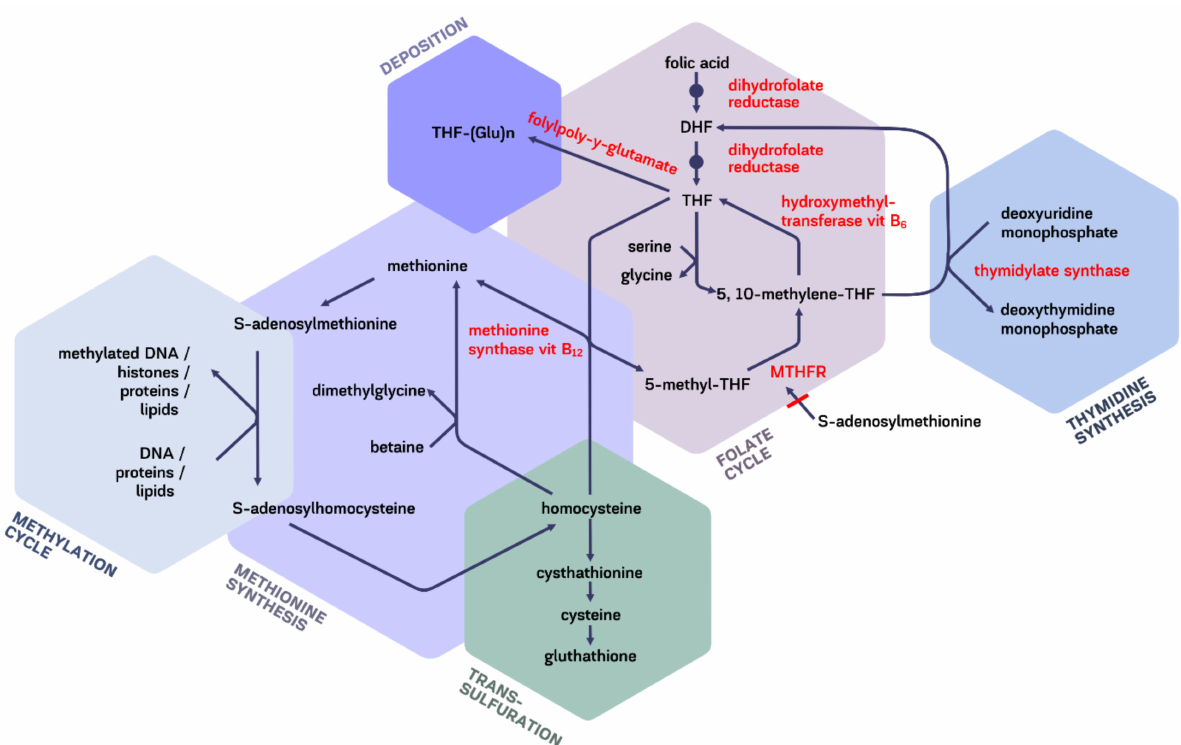
Figure 3. Cellular cycles involving folates. The names of enzymes are marked by red. Intracellular transformations of 5-methyl-THF may depend on the way of absorption. The steps where NAD + /NADH is involved are marked by blue circles. Adapted from